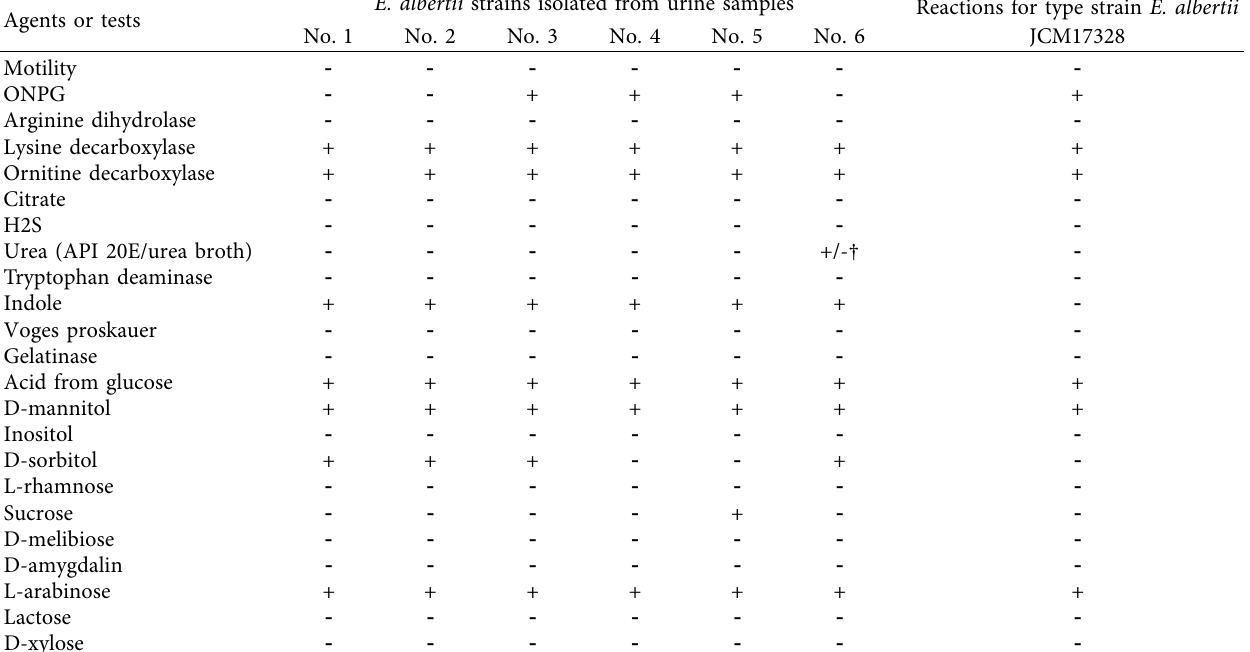
Table 2: Biochemical properties of E. albertii strains.